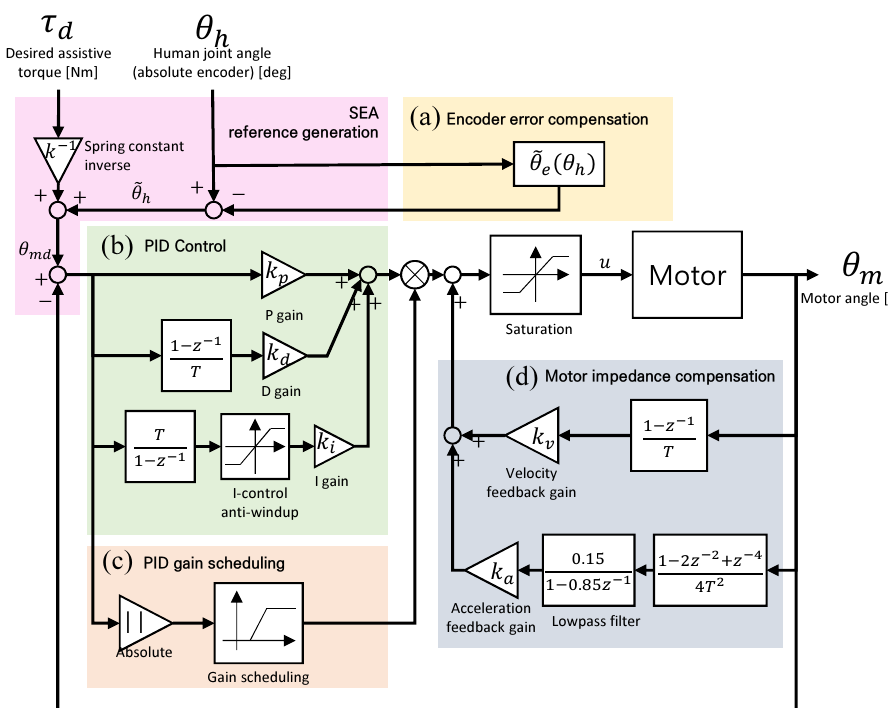
Figure 4. Assistive torque control of the series elastic actuation (SEA)